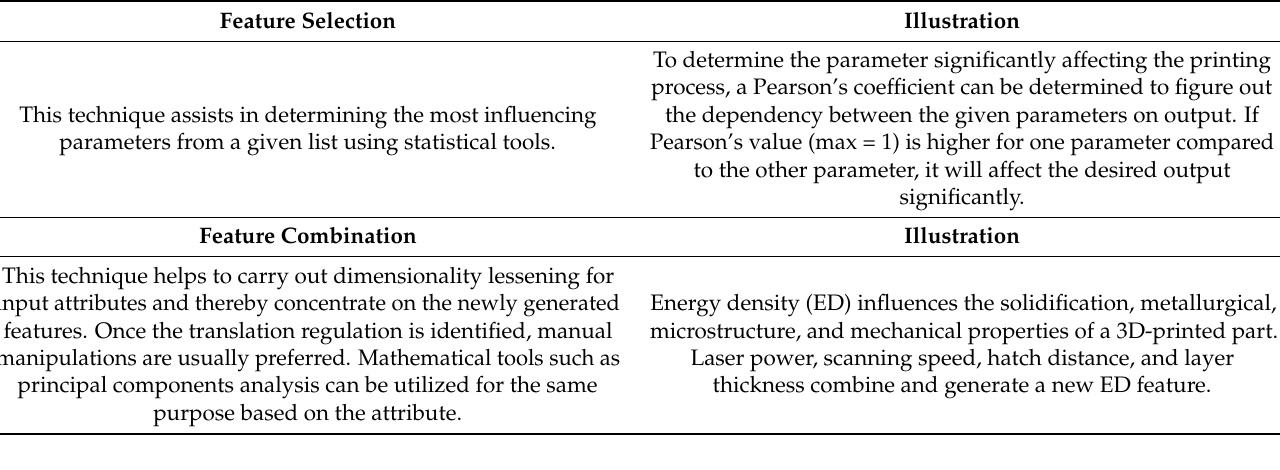
Table 8. Techniques for preprocessing of a given dataset